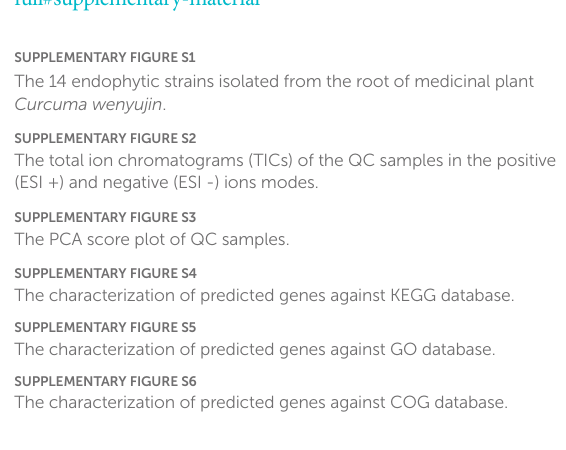
SUPPLEMENTARY FIGURE S2 The total ion chromatograms (TICs) of the QC samples in the positive (ESI +) and negative (ESI -) ions modes. SUPPLEMENTARY FIGURE S3 The PCA score plot of QC samples. SUPPLEMENTARY FIGURE S4 The characterization of predicted genes against KEGG database. SUPPLEMENTARY FIGURE S5 The characterization of predicted genes against GO database. SUPPLEMENTARY FIGURE S6 The characterization of predicted genes against COG